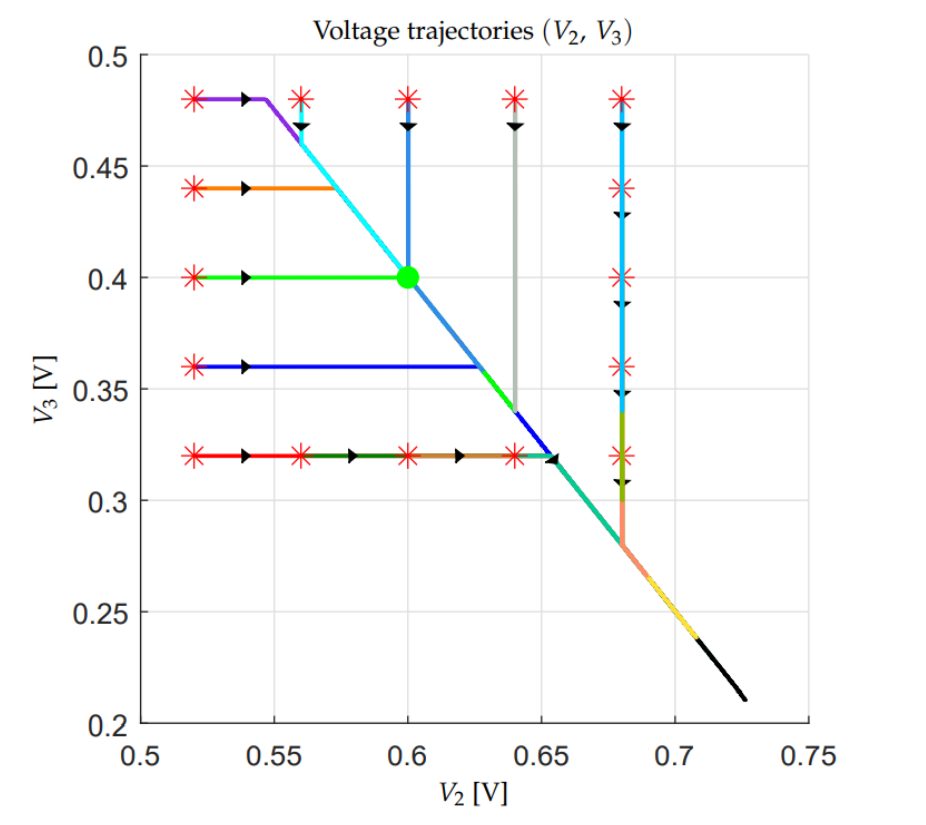
Figure 16. Instability of the Configuration Voltage Vector V m = [ 5 3 2 ] T when V d = 0.7 and I out =